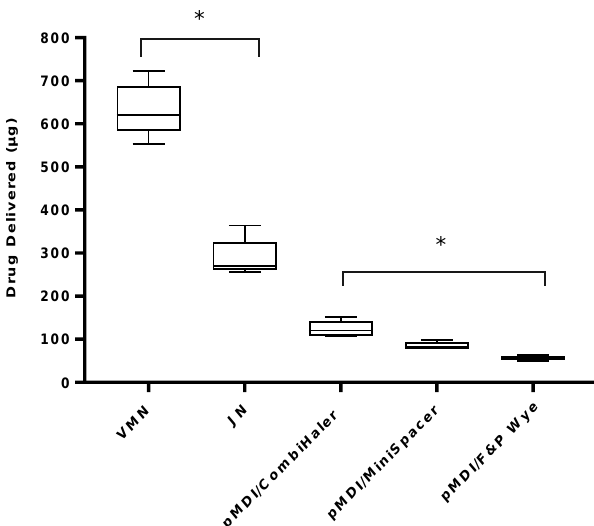
Figure 4. Aerosol drug delivery using standard adult settings during simulated mechanical ventilation with active humidification. Three different devices, VMN, JN and pMDI, using three different spacer/adapter types, were tested. pMDI actuation was at the start of inhalation. Results are presented as mean ± SD µ g drug delivered. * Denotes statistical significance at p < 0.0001.